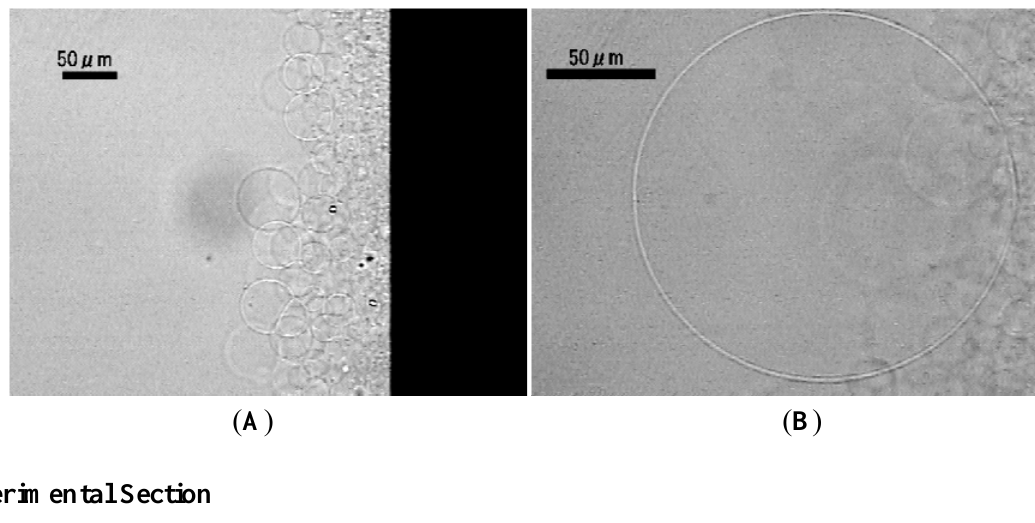
Figure 6. GV formation from lipid deposit on a wire formation electrode upon application of ac voltage (3.0 Vpp, 2.0 Hz) with a planar counter electrode ( A , 100 min). A GV as large as 180 µm ( B , 110 min) was observed. The wire electrode appears as a dark shadow on the right hand side of the image